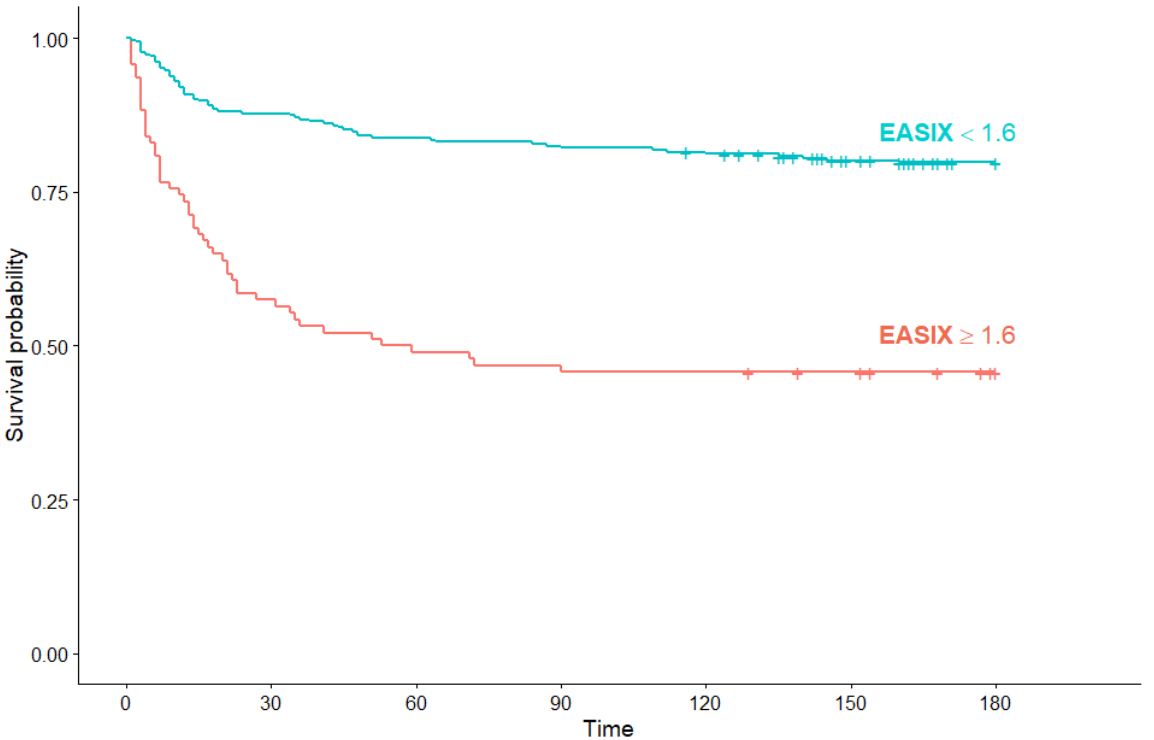
Figure 8. Kaplan–Meier survival curves for overall survival in non-hematological COVID-19 patients according to EASIX score.